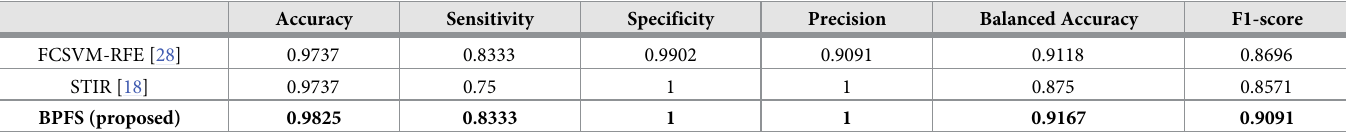
Table 2. Classification effectiveness analysis on the THCA cancer